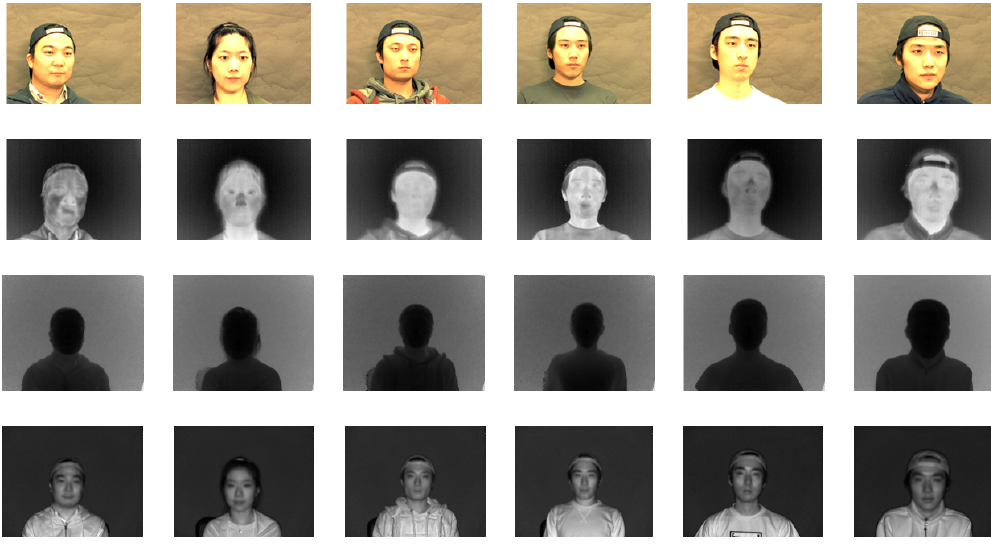
Figure 14. Example images in our face database including 3D, visible and thermal-IR information. The first row shows some color images from the visible camera. The second row shows images from the thermal-IR camera. Distance images from the ToF camera are shown in the last row.